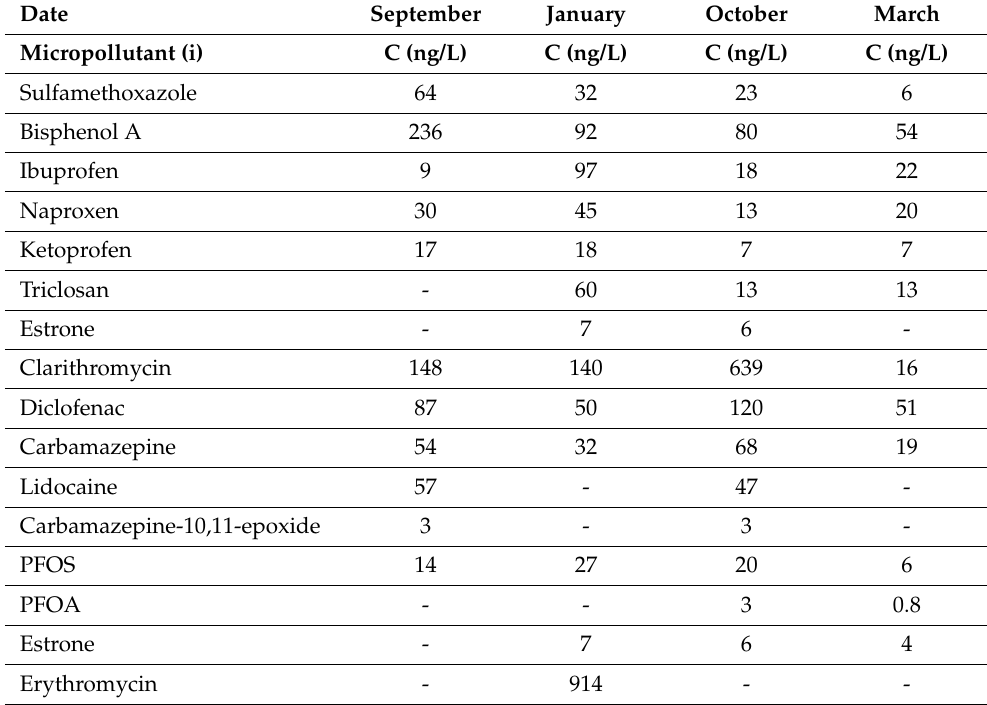
Table 6. The temporal evolution of the concentration of the micropollutants in B 2 from September to March. A dash ‘-’ is used when C it at the site studied are <